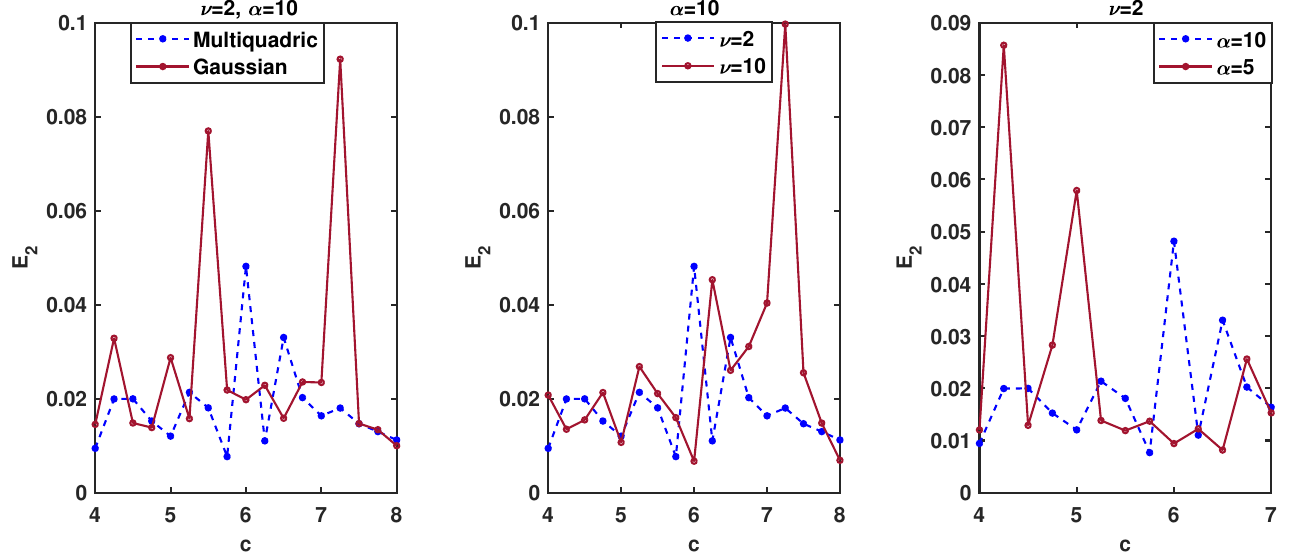
Figure 2. Comparison E 2 with respect to the shape parameter c on the domains Ω 1 at time T = 1 for Example 2 where τ =